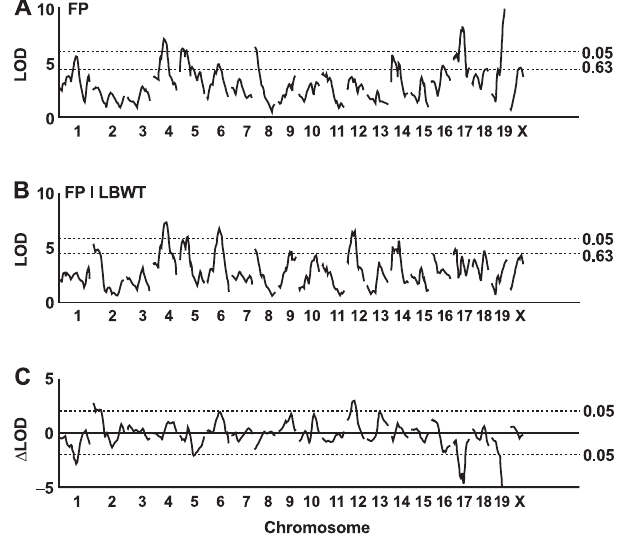
Figure 5. Genome-Wide Scans for Multiple Fat Pad Traits at 2 cM Resolution Genome scans shown are (A) the four fat pad traits (inguinal, gonadal, peritoneal, and mesenteric fat pad weight) with sex as an additive covariate; (B) the four fat pad traits with sex and lean body weight as additive covariates; and (C) the difference in LOD scores between scans in (A) and (B). FP, the four fat pad traits; LBWT, lean body weight. DOI: